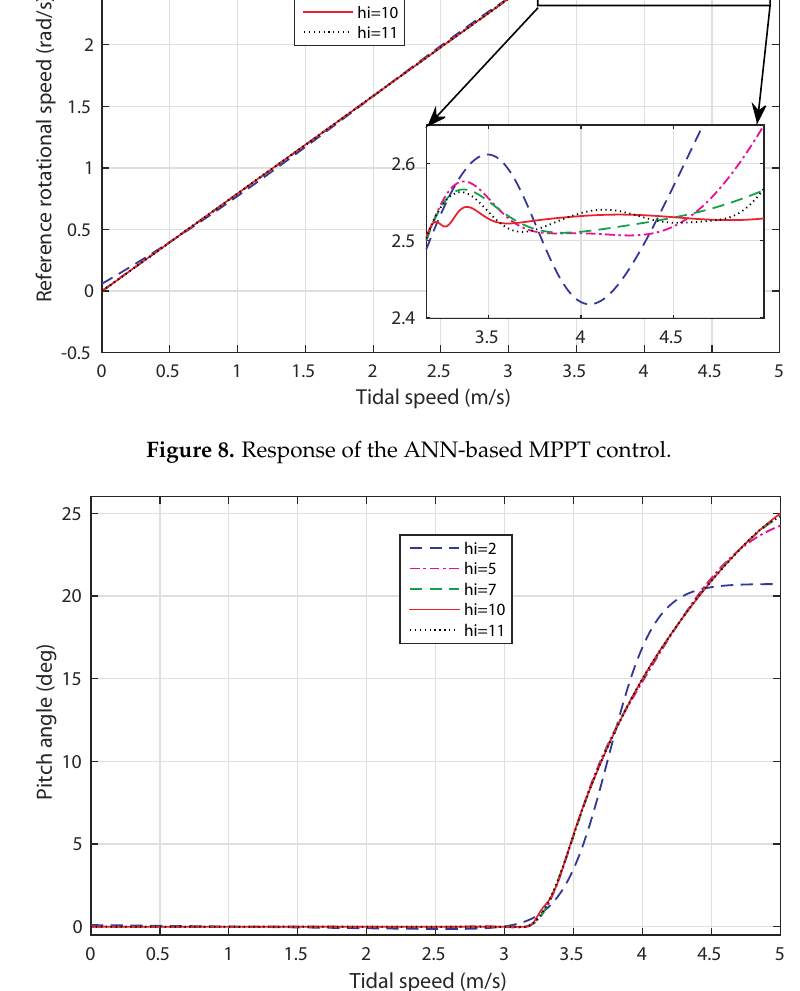
Figure 9. Response of the ANN-based pitch angle